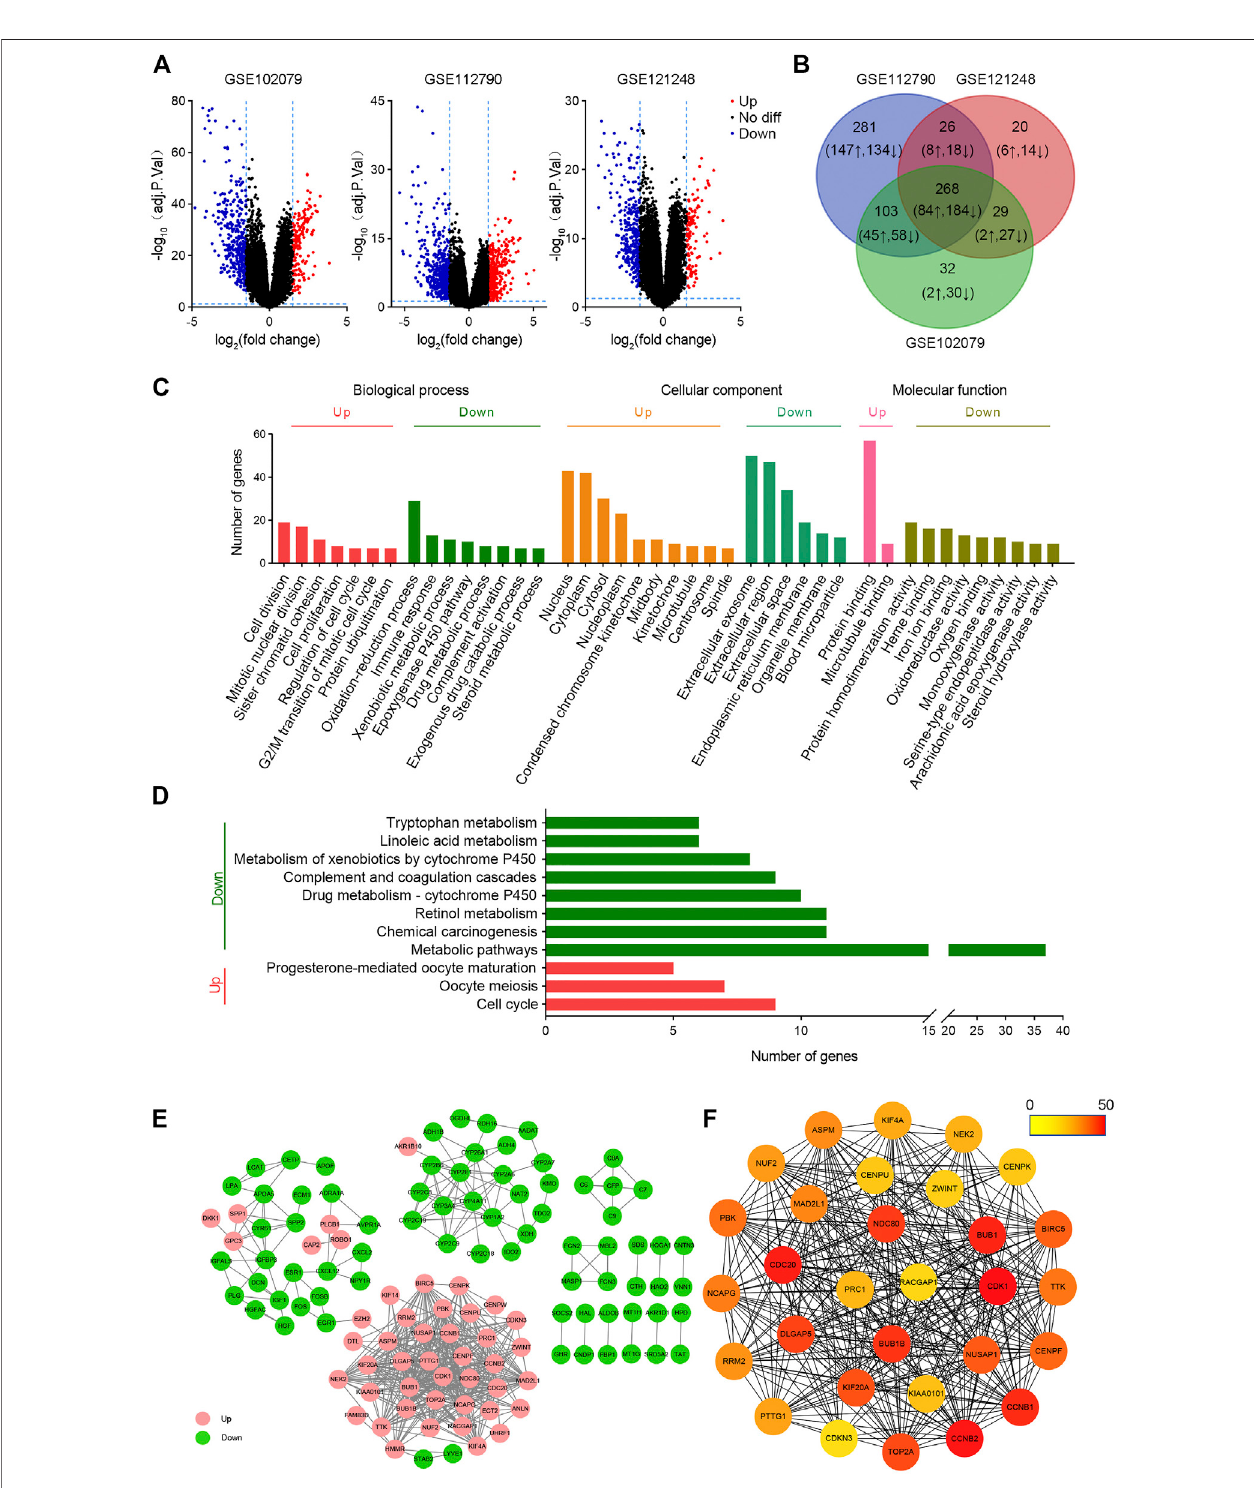
FIGURE1| BioinformaticscreeningofHCChubgenes. (A) Volcanicmapsofdifferentially expressedgenesinHCCinGSE102079,GSE112790, andGSE121248 data sets. The p value < 0.05 and |logFC| > 1.5 were used as the selection criteria. (B) Venn plots of differentially expressed genes in GSE102079, GSE112790, and GSE121248 data sets. (C) GO analysis of common differentially expressed genes. (D) KEGG analysis of common differentially expressed genes. (E) Protein – protein interaction networks ofdifferentially expressed genes. (F) Top 30 hub genes were screened by MCC. The color ofthe circle representsthe number ofproteins that interacts with it.